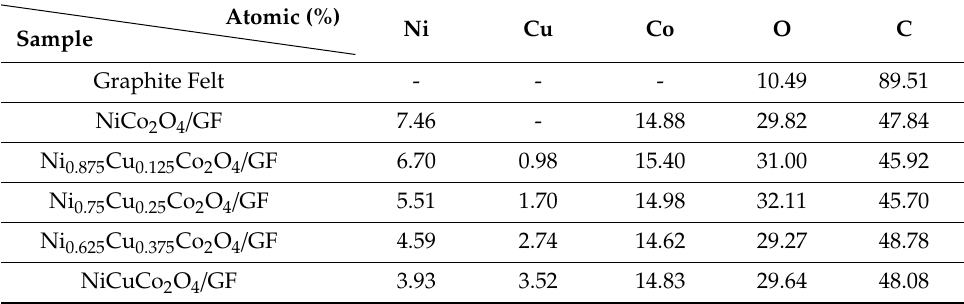
Figure 3. TEM image of Ni 0.75 Cu 0.25 Co 2 O 4 /GF electrode ( a ), HR-TEM images of the electrode surface ( b ), SAED patterns ( c ), and STEM-EDS mapping for all elements ( d ). Table 1. Atomic compositions on Ni 1 − x Cu x Co 2 O 4 /GF electrodes obtained by the EDS analysis.